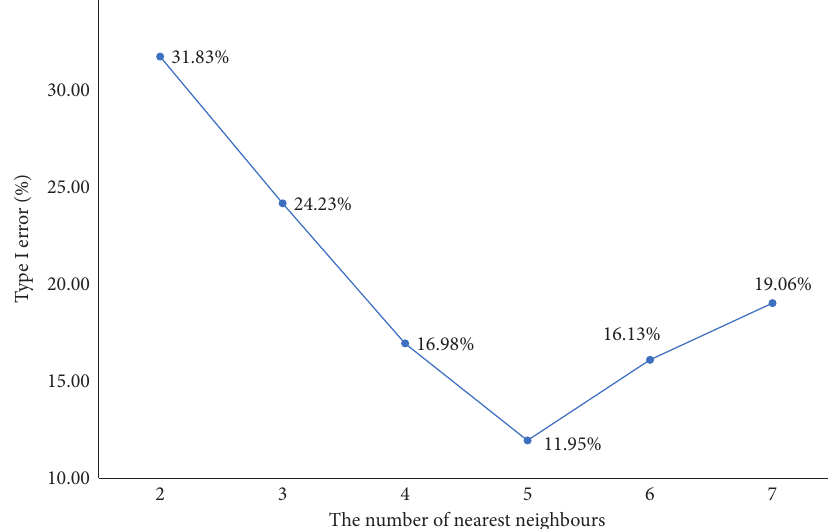
Figure 8: Variations of Type I error with the increased number of nearest neighbors for